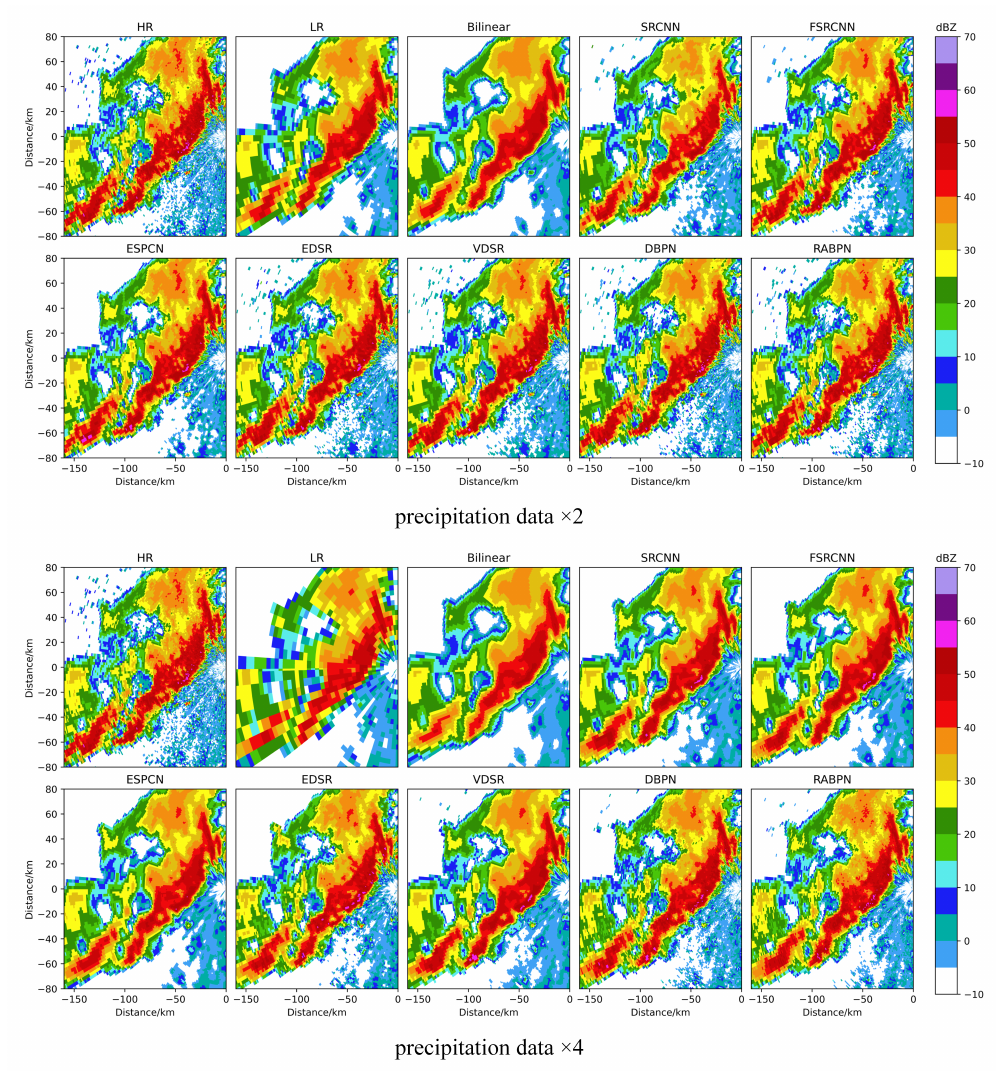
Figure 10. Comparison of super-resolution reconstruction results of precipitation